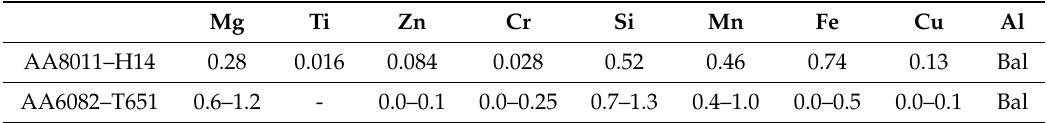
Table 1. Chemical compositions [28,29].